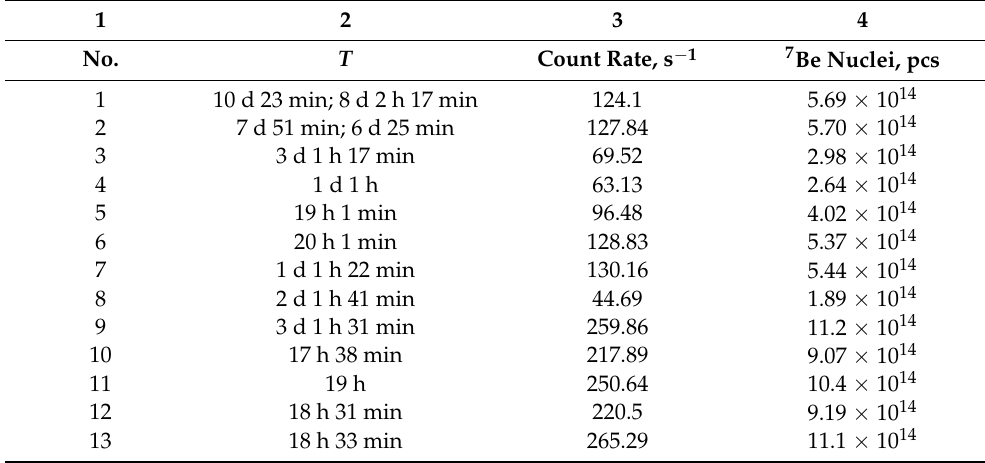
Table 2. Data on the measurements of the target. Columns: 1—serial number of targets; 2—time between the end of neutron generation and the beginning of the measurement of the target activity T ; 3—count rate, s − 1 ; 4—number of the formed 7 Be nuclei,